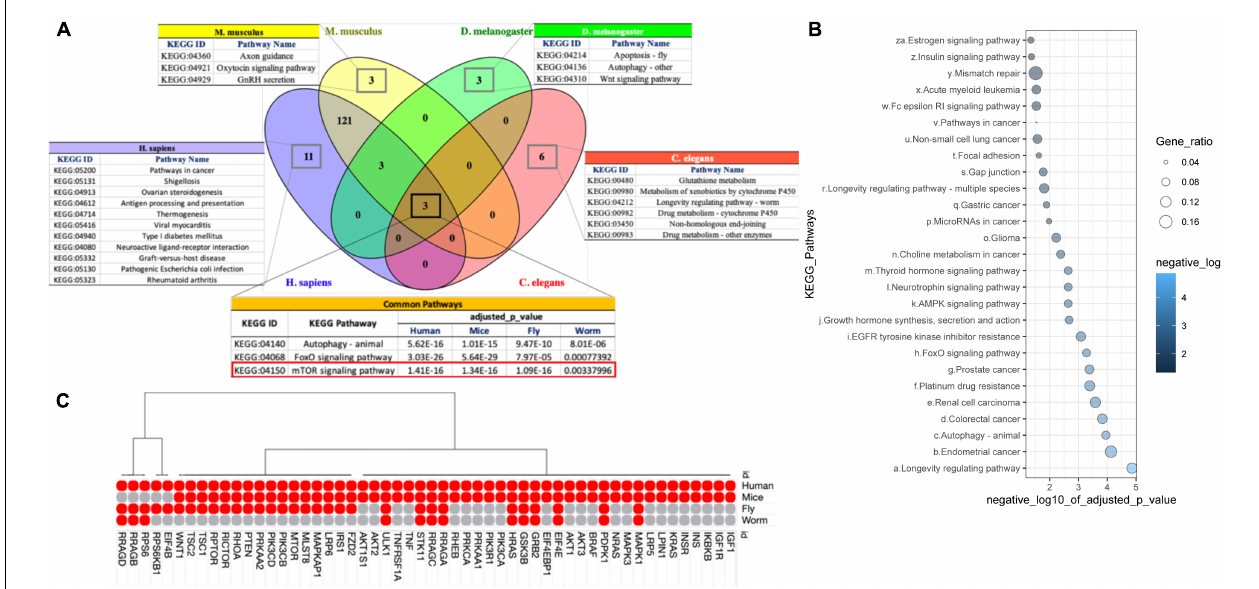
FIGURE 3 | Cross-species pathways comparison. (A) Gene Set Enrichment Analysis (GSEA) of PPIN genes identified three KEGG pathways: Autophagy – animal (KEGG:04140), FoxO signaling pathway (KEGG:04068) and mTOR signaling pathway (KEGG:04150) are common within all four studied species. Pathways identified as species specific are also highlighted separately. (B) GSEA of common orthologs (111 genes) in PPIN of all four species identified 27 KEGG pathways with P -value threshold < 0.05. The size and color of each dot represent the adjusted P -value (after Bonferroni correction) and gene ratio, respectively for each pathway in the analysis. The gene ratio was calculated by subtracting the number of genes present in a particular pathway with the number of genes represent the respective pathway from our data. (C) The dot plot represents the number of genes from mTOR signaling pathway (KEGG:04150) for each species in our analysis. The present or absent of the orthologs within the species implies that the interaction of proteins involved in mTOR signaling pathway may be somewhat limited to each